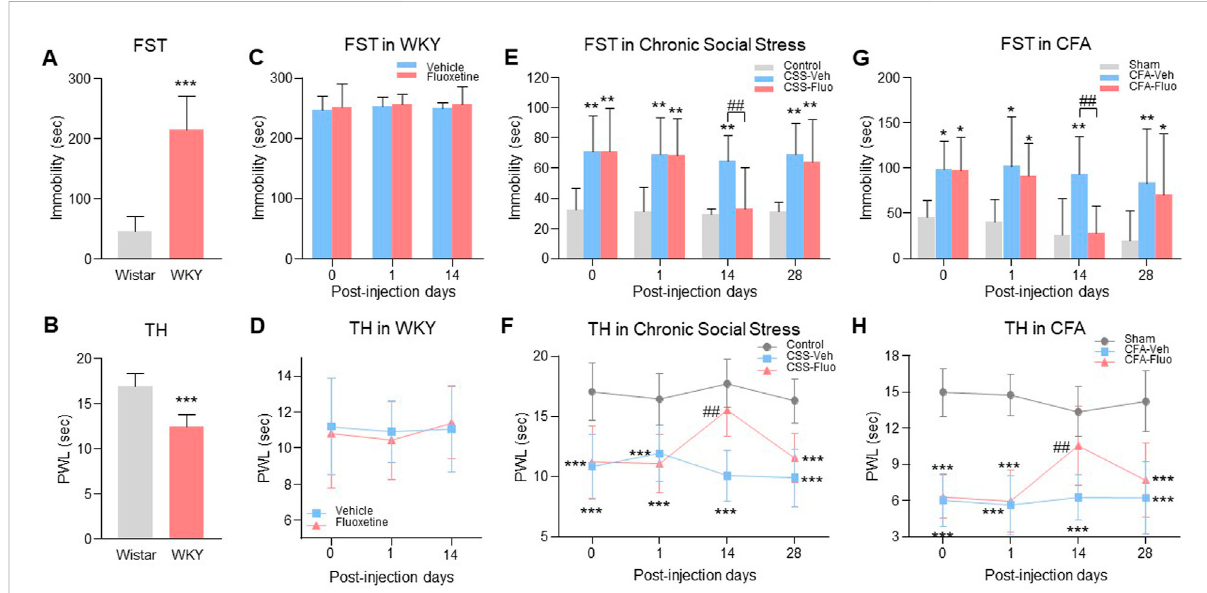
FIGURE 1 Rats with comorbid pain and depression displayed resistance to fl uoxetine maintenance treatment. (A) WKY rats showed prolonged immobility time in FST as compared to the Wistar rats. (B) The decrease of thermal pain threshold in TH appeared in WKY rats. (C) Fluoxetine treatment did not changeimmobilitytimeinFSTonWKYrats,indicatingtheWKYratswereresistanttothe fl uoxetineeffect. (D) FluoxetinehadnoeffectonPWLofWKY rats in TH compared with vehicle treatment group. (E) Chronic fl uoxetine administration reversed the increase of immobility time in FST arising in chronic social stress rats on day 14 post injection, but failed on day 28. (F) Fluoxetine attenuated chronic social stress-induced PWL decreases on day14,butnotonday28. (G) IntheCFAmodel, fl uoxetinealsoreversedtheimmobilitytimethatwassigni fi cantlyincreasedbyCFAintheFSTonday 14,butnotonday28. (H) Likechronicsocialstressrats,CFAratsshowedthesametrendsinTH.Thedataarepresentedasthemean±SD( n =8).* p < 0.05, ** p < 0.01 and *** p < 0.001 comparedto theWistarrats, vehicle-treated WKY rats, Control inchronic social stress orSham in CFA; ## p < 0.01, CSS-Veh versus CSS-Fluo and CFA-Veh versus CFA-Fluo. Sec indicates second; FST, forced swim test; TST, tail suspension test; TH, thermal test; PWL, paw withdrawal latency; CSS, chronic social stress; Veh, vehicle; Fluo, fl